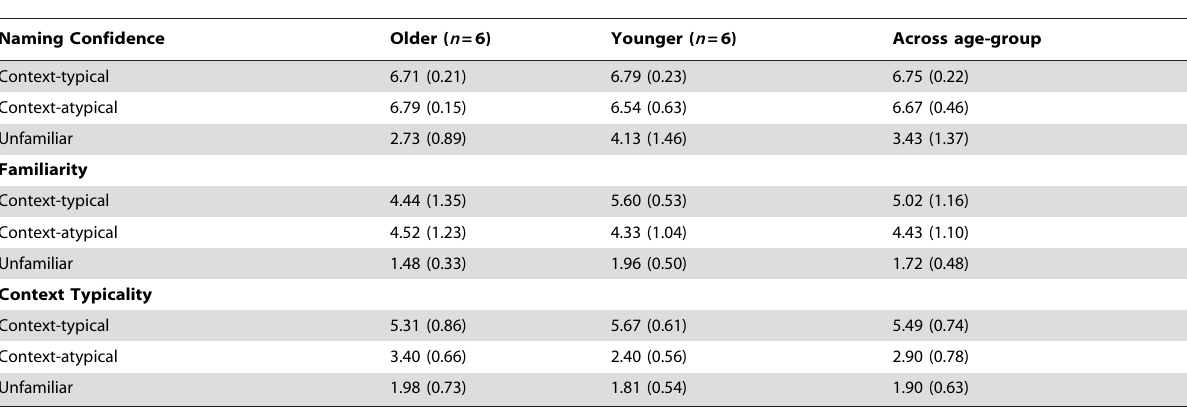
Table 2. Mean naming confidence, familiarity, and context typicality ratings.